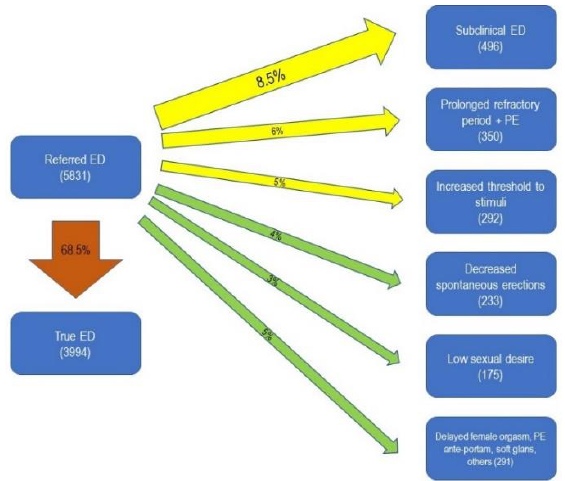
Figure 1. Prevalence of final diagnoses in patients who reported erectile dysfunction (ED) at the first visit to the andrology clinic. ED: Erectile Dysfunction; PE: premature ejaculation.